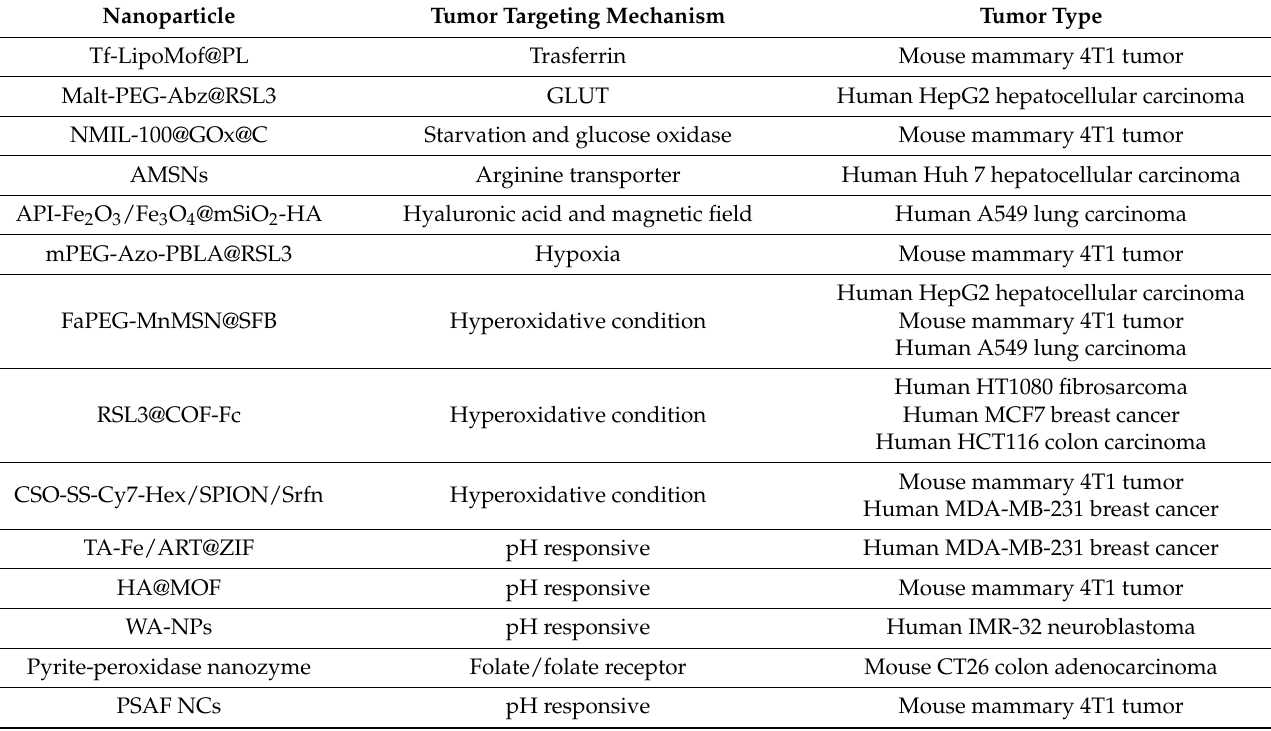
Table 2. Nanoparticles for tumor